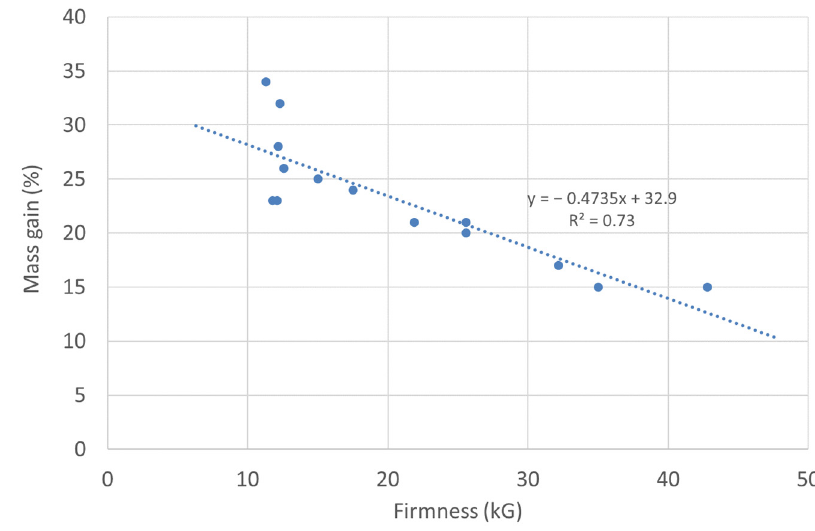
Figure 1. Relationship between mass gain and firmness of apple cubes before VI.